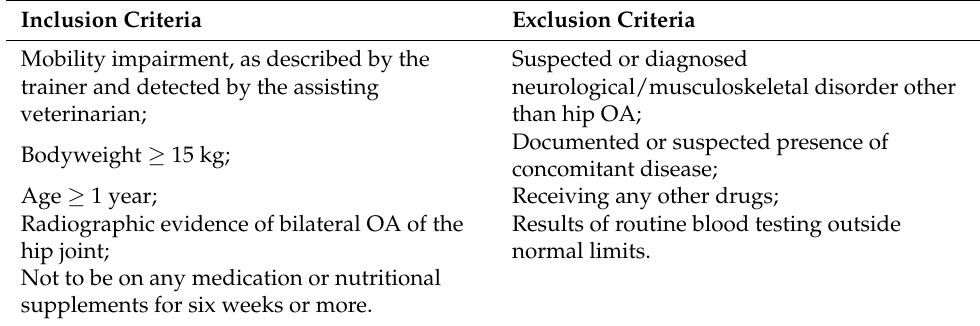
Table 1. Inclusion and exclusion